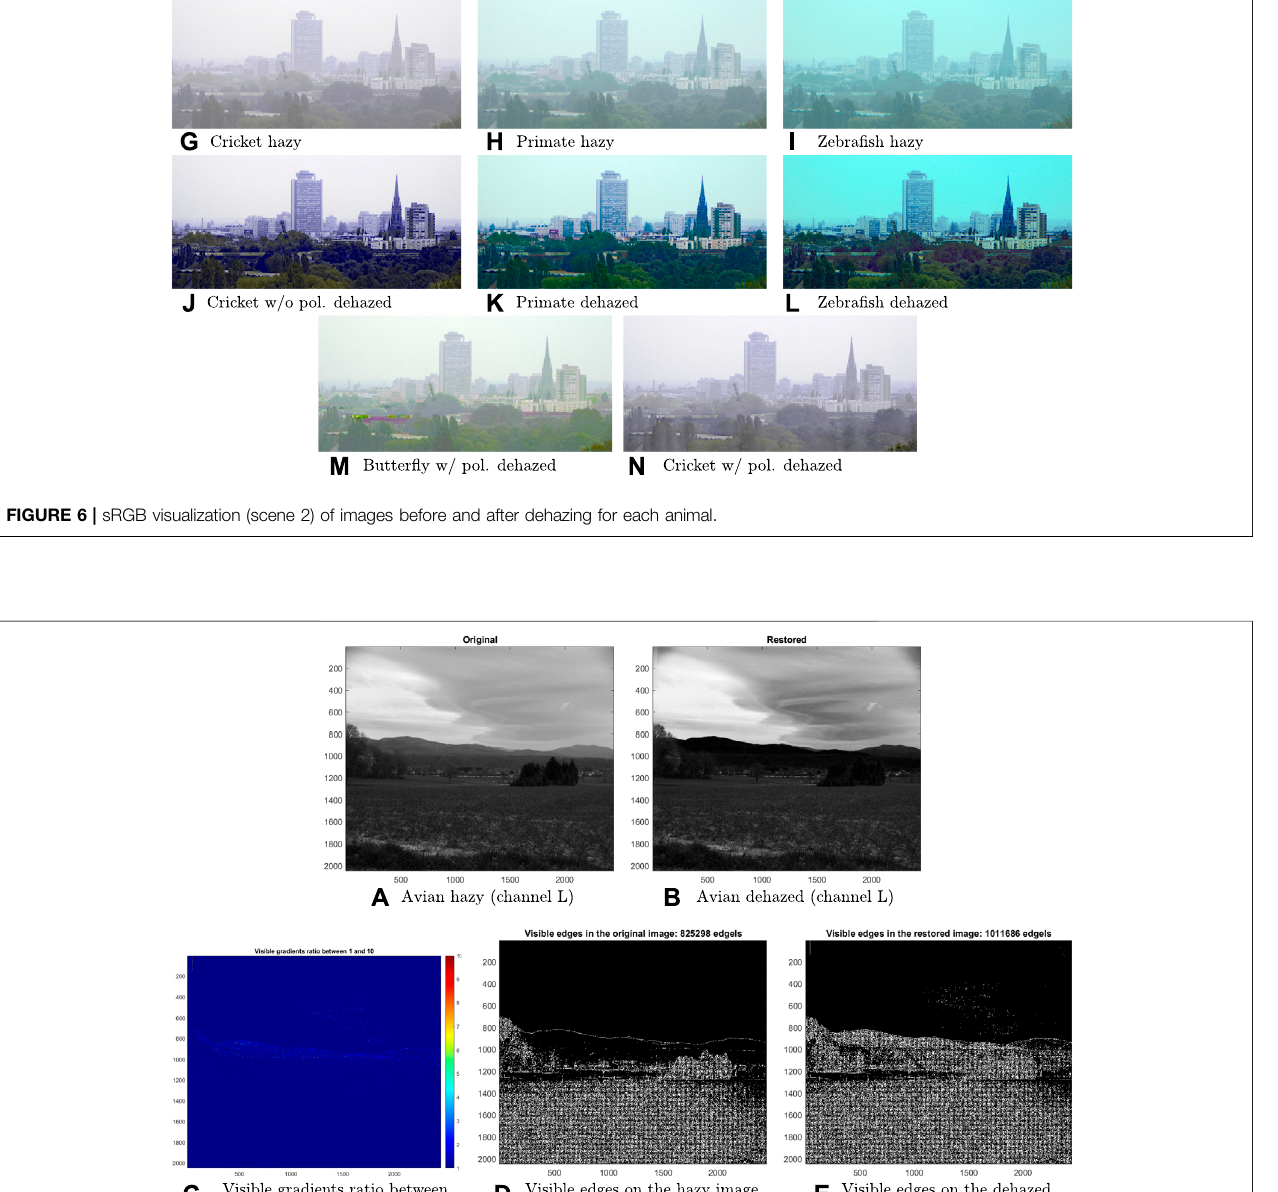
Frontiers in Computer Science |